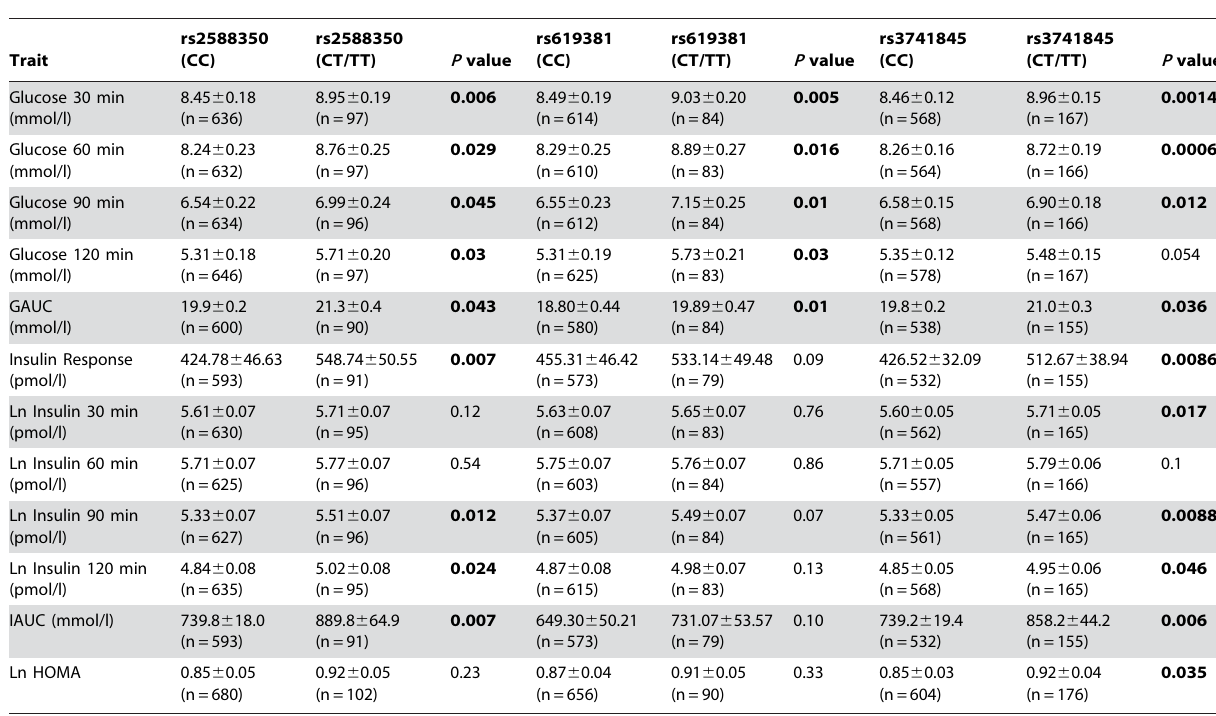
Table 5. Associations with insulin and glucose metrics from OGTT in non-diabetic AFDS